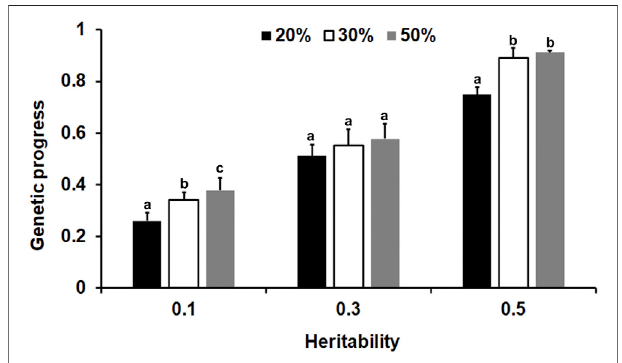
FIGURE 6 | The in fl uence of the genotype ratio and heredity on the genetic progress of selection. Different lowercase letters above the bars represent signi fi cant differences ( p <